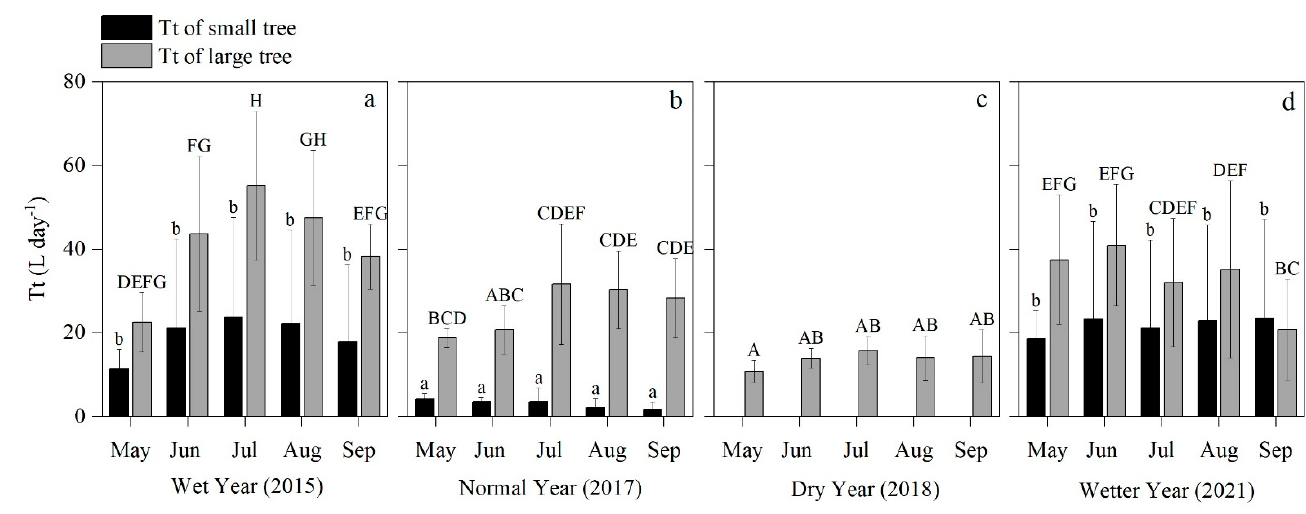
Figure 3. Mean value ± standard deviation of monthly mean T t of small and large trees in the ‘wet’ ( a ), ‘normal’ ( b ), ‘dry’ ( c ), and ‘wetter’ ( d ) years. Lower case letters indicate the difference in the T t of small trees in different hydrological years ( n = 331, p < 0.001), upper case letters denote differences in the T t of large tree in different hydrological years ( n = 434, p < 0.001).